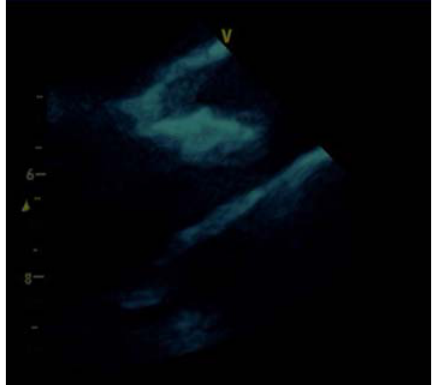
Figure 3: Aortic valve vegetation in parasternal